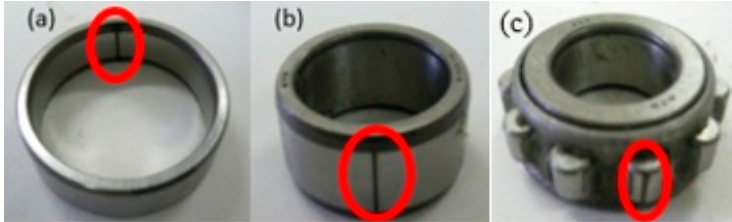
Figure 7. Bearing for condition diagnosis: ( a ) inner ring defect; ( b ) outer ring defect; and ( c ) roller element defect.